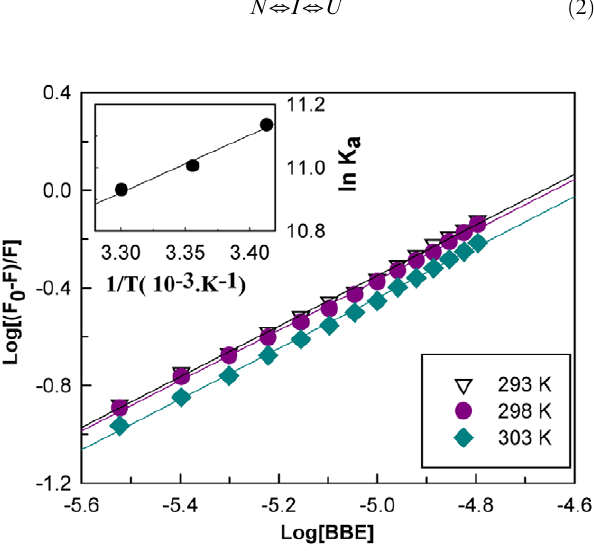
Figure 4. The binding and thermodynamic parameters of BBE- BSA complex. Log[{(F0-F)}/F ] versus log[Q] plots of the BBE-BSA binding data at three different temperatures for the determination of the association constant (K a ) and number of binding sites (n). The inset shows the van’t Hoff plot for BBE-BSA interaction for the determination of thermodynamic parameters.